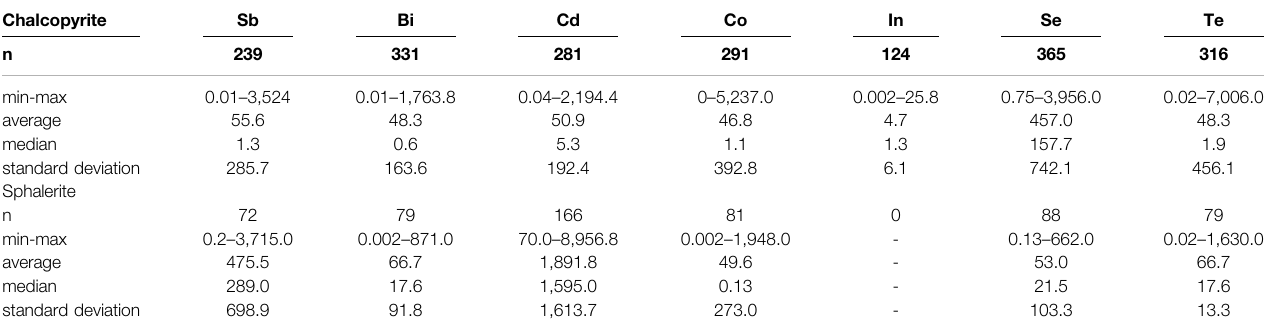
TABLE 2 | Summary of select trace element concentrations (ppm) in chalcopyrite and sphalerite from 28 volcanogenic massive sul fi de deposits ( Supplementary Table 1 ; data sources therein ). Chalcopyrite Sb Bi Cd Co